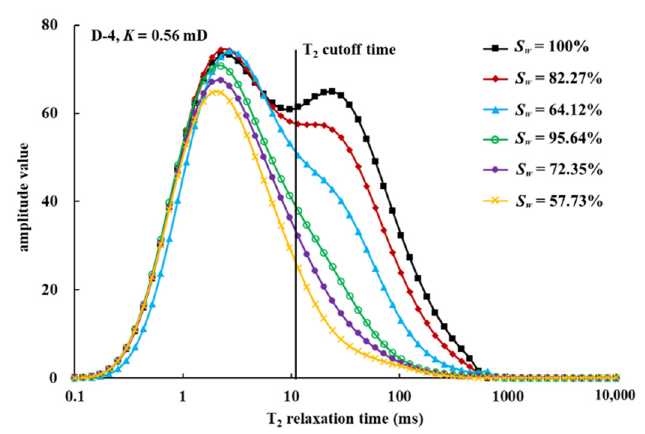
Figure 2. T 2 spectrum curve of core plug D-4 under different water saturation.